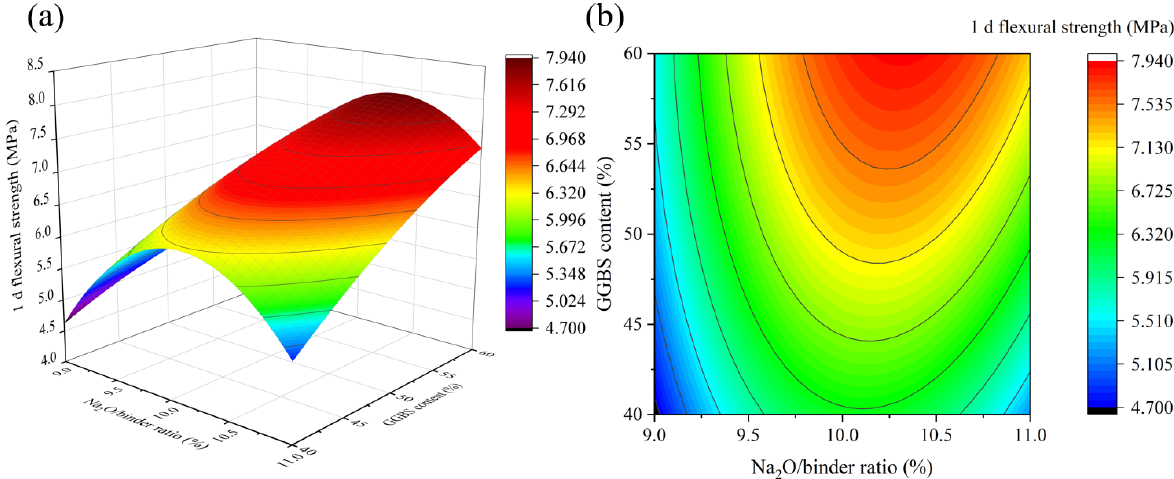
Figure 9. The interaction effect of Na 2 O/binder ratio and GGBS content on 1 d flexural strength: ( a ) 3D response surface; ( b ) contour diagram.